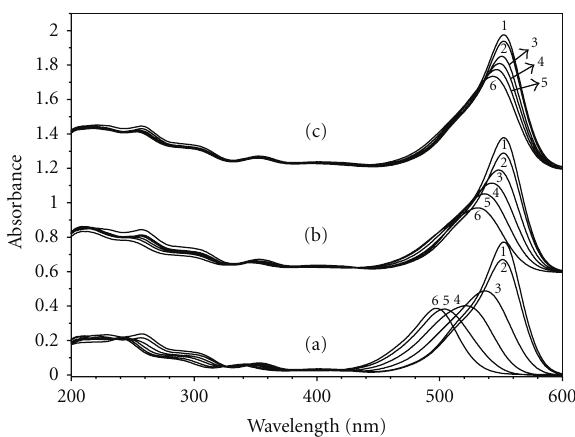
Figure 5: UV-vis spectral changes of RhB aqueous solution (5mg/L) at di ff erent irradiation times; spectra 2, 3, 4, 5, and 6 denote di ff erent irradiation times of 0, 1, 1.5, 2.0, and 2.5 hours, respectively. The spectrum 1 is the UV-vis spectrum of RhB aqueous solution before the addition of TiO 2 nanofibers as photocatalyst. Three sets of spectra (a), (b), and (c) belong to TiO 2 nanofibers obtained at 500 ◦ C, 600 ◦ C, and 700 ◦ C, respectively.